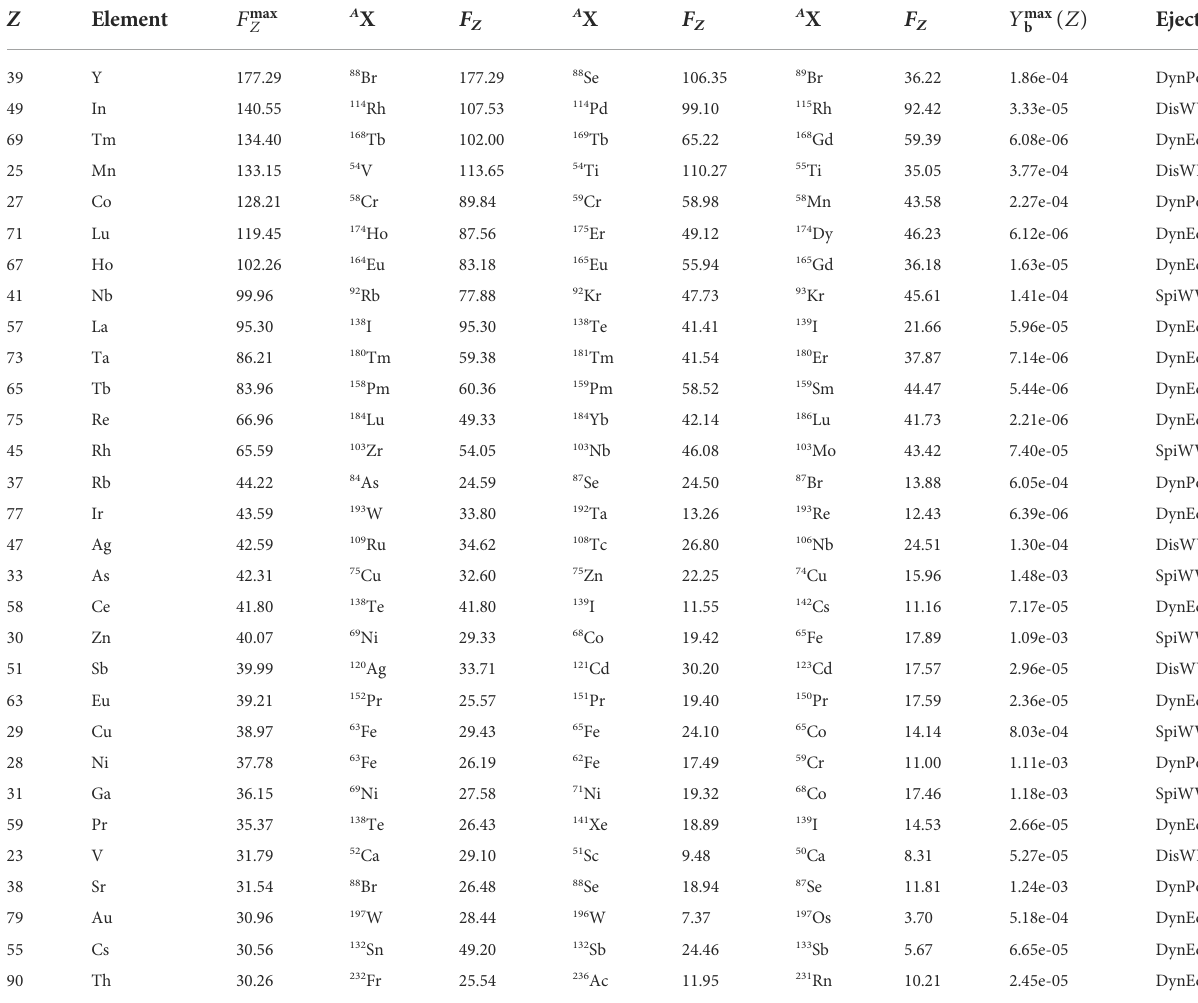
TABLE 3 30 most sensitive elements with the relative maximum local sensitivity ( F max Z ) and the top three A X (n, γ ) reactions with the strongest local sensitivities( F Z )fortheconsideredejectatrajectory.Foreachelement,thetrajectorywasselectedastheonepredictingthemaximumabundance Y max ( Z ) for the baseline b